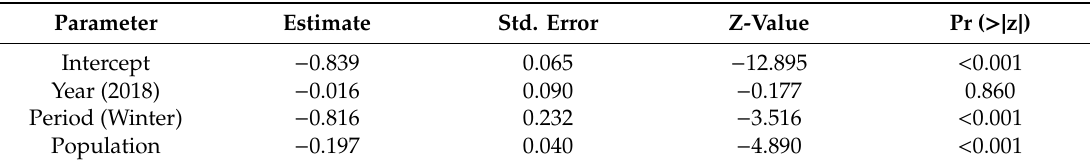
Table 1. Result of Generalized Additive Model (GAM) testing the relationship between ZanzaMapp records of low ( ≤ 3) and high ( > 3) mosquito abundance and human population density, temperature, and hour of the day in 2017 and 2018. Human population density was standardized (mean = 376.282, standard deviation = 375.856).